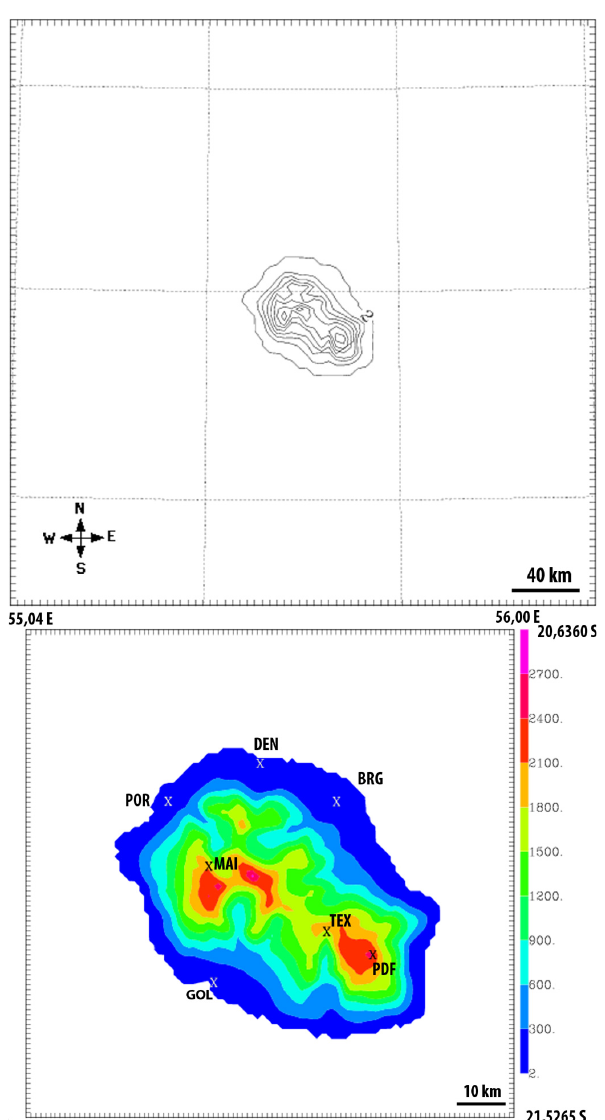
Fig. 1. The used nested model domains (horizontal resolutions: 4km (top), 1km (bottom)). The place names used in this paper are indicated on the bottom panel. The colorscale represents the elevation of the terrain in m (from MesoNH